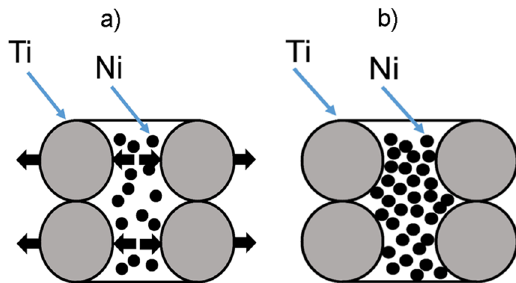
Figure 10. Schematic showing the interaction between the particles sintered below 9420C a) general positive flux of Ni atoms toward the Ti particles in the radial direction and b) powder particles touching each other resulting in self-diffusion and axial